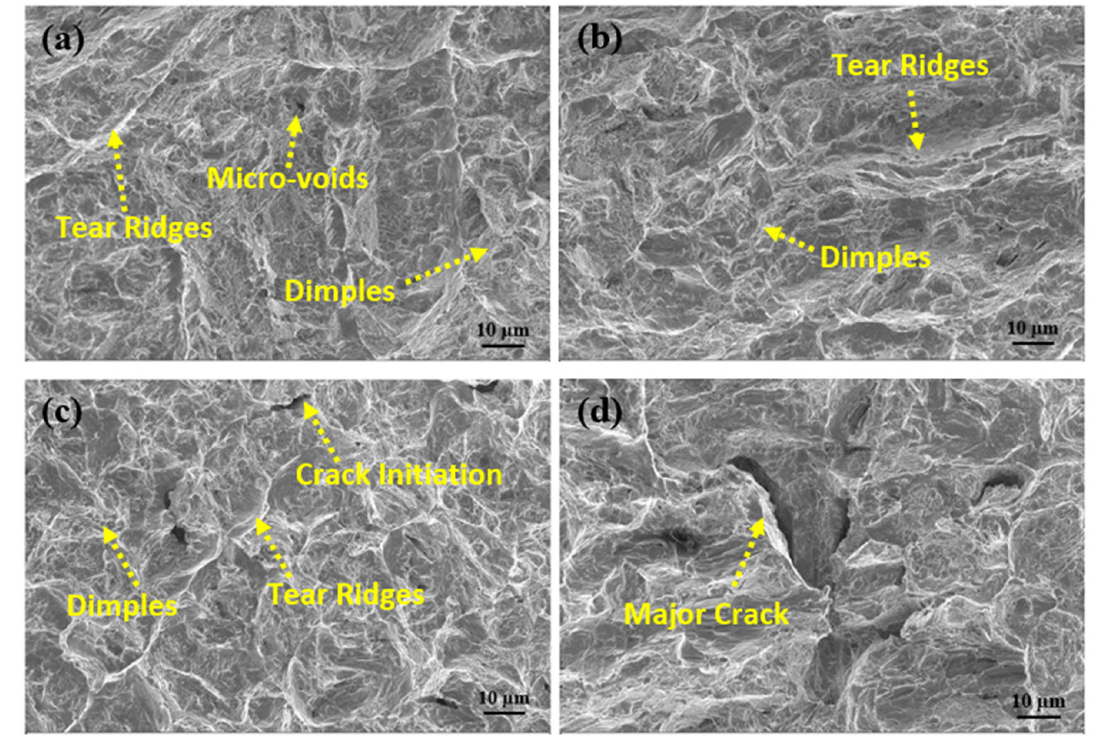
Figure 17. FESEM of tensile fractography surface of Cu alloy and Cu-(3, 6, 9) wt.% SiC-Gr hybrid composites.